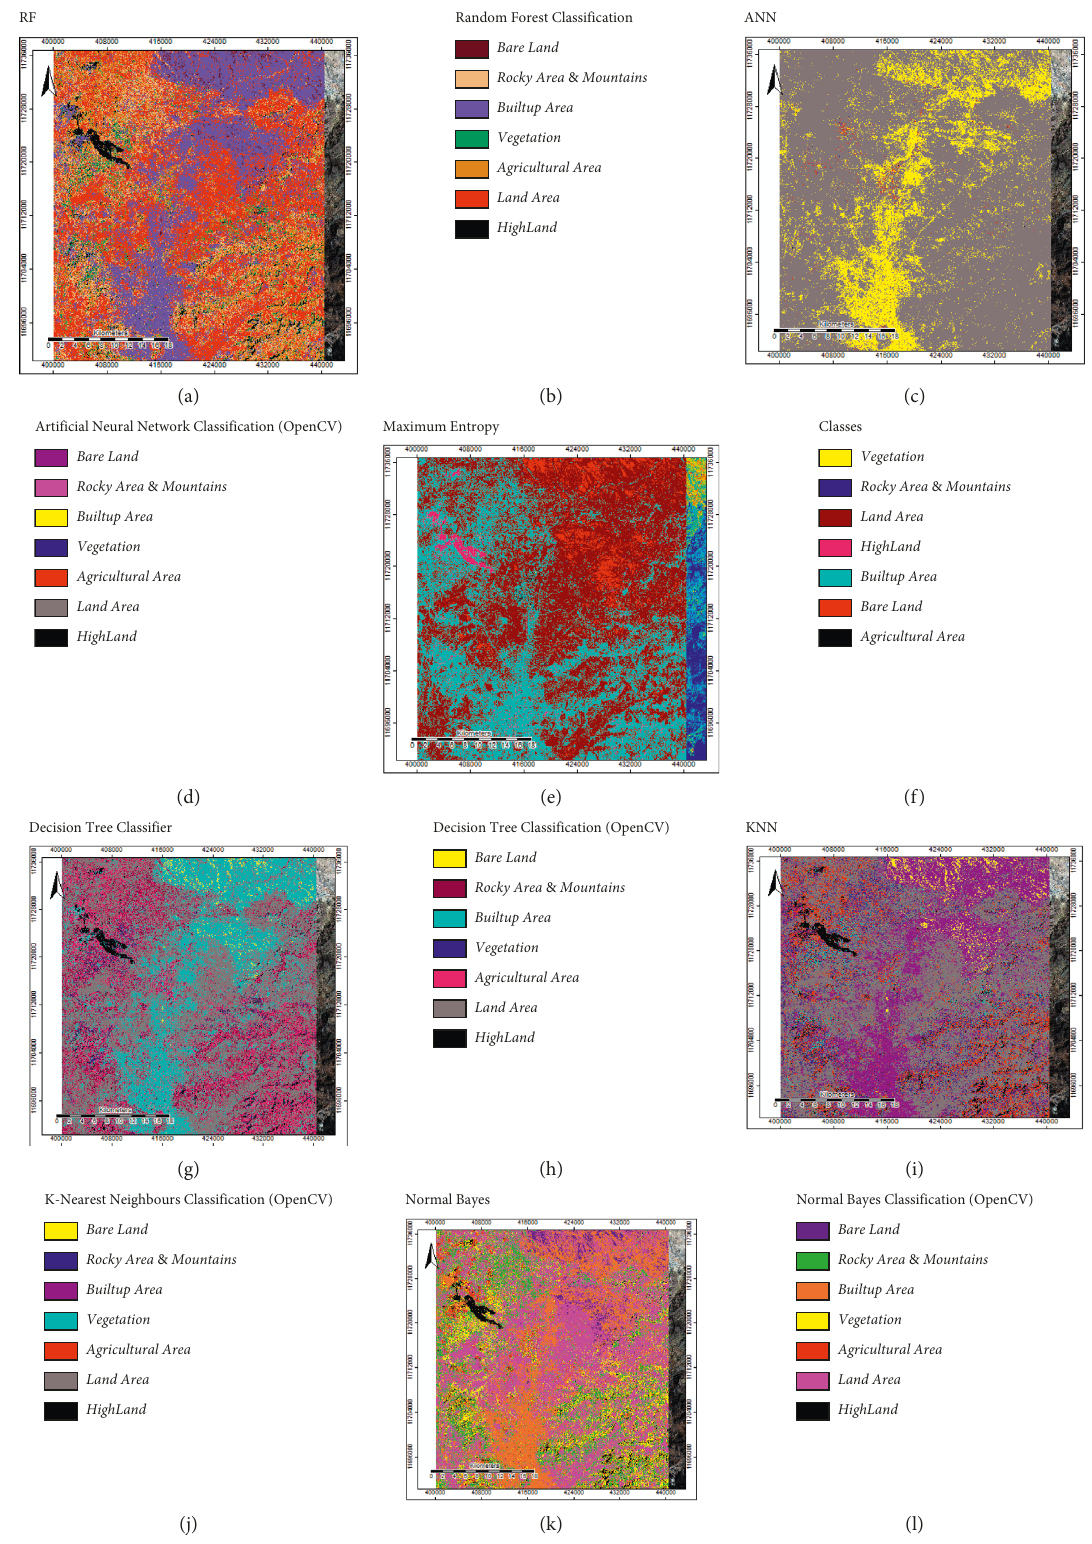
Figure 5: Group 1: land changes classification using machine learning methods with Sentinel-2A. (a, b) RF classifier. (c, d) ANN classifier. (e, f) ME classifier. (g, h) DTC classifier. (i, j) KNN classifier. (k, l) NB